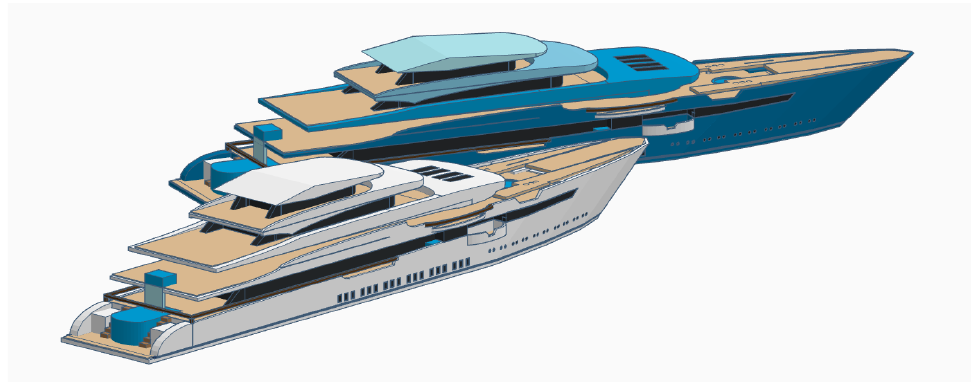
Figure 8. Example of occlusion.